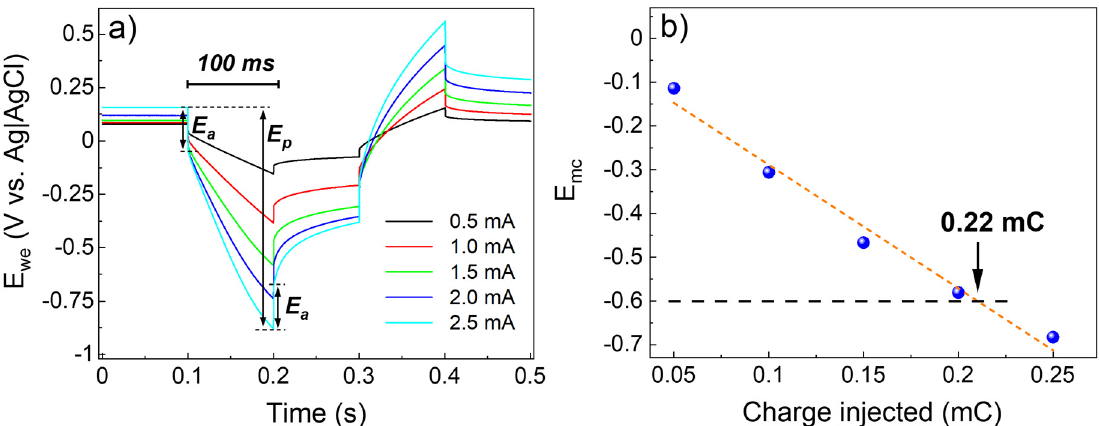
Figure 11. Results of the voltage transient measurements performed on ALD-prepared IrO 2 . ( a ) Shows the voltage of the working electrode (E we ) as function of time for squared current pulses of 0.5, 1.0, 1.5, 2.0, and 2.5 mA. ( b ) Reports the maximum polarization (E mc ), calculated by the difference between the peak voltage (E p ) and the access voltage (E a ), as function of the charge injected. By linear regression of the data (orange dashed line), it was possible to calculate the charge injection capacity to be 0.22 ± 0.01 mC ∙ cm − 2 for E mc = − 0.6.